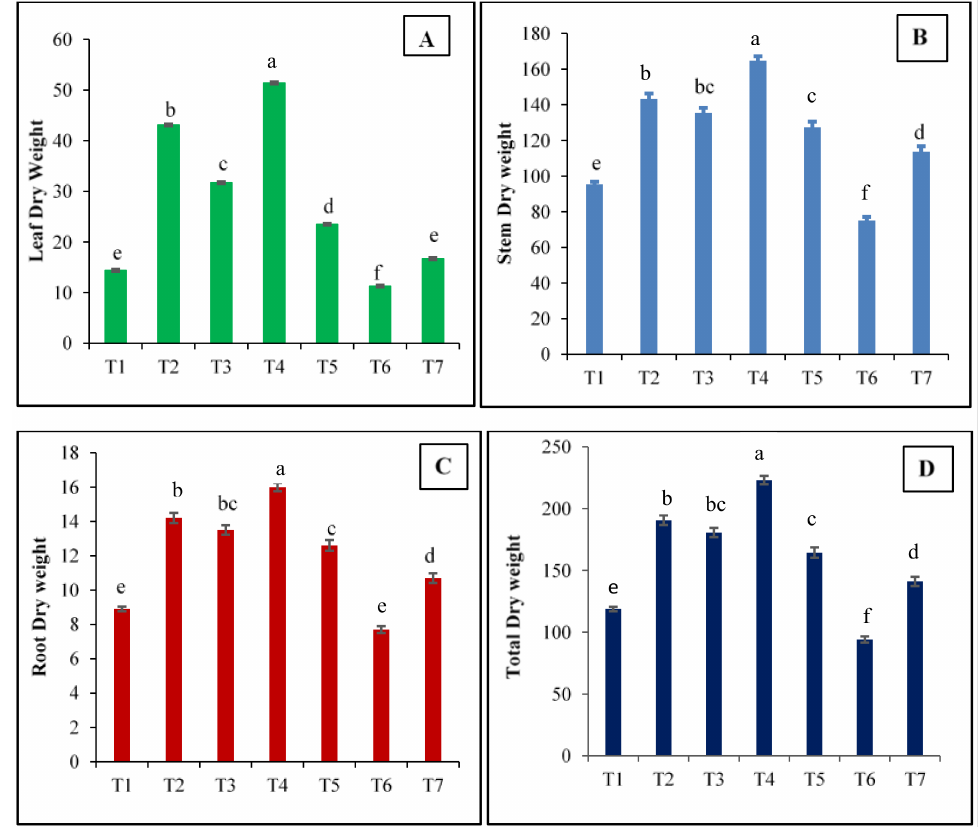
Figure 2. Effect of different treatments of CO 2 and temperature on leaf dry weight ( A ), stem dry weight ( B ), root dry weight ( C ), and total dry weight ( D ) of tomato at harvest. T1—ambient CO 2 and temperature, T2—550 ppm, T3—550 ppm + 2 ◦ C, T4—700 ppm, T5—700 ppm + 2 ◦ C, T6—Elevated temperature (+2 ◦ C), T7—open field (control). Vertical bars indicate the Standard Error. Vertical bars with same letter(s) do not differ significantly at p = 0.05 level as per Tukeys